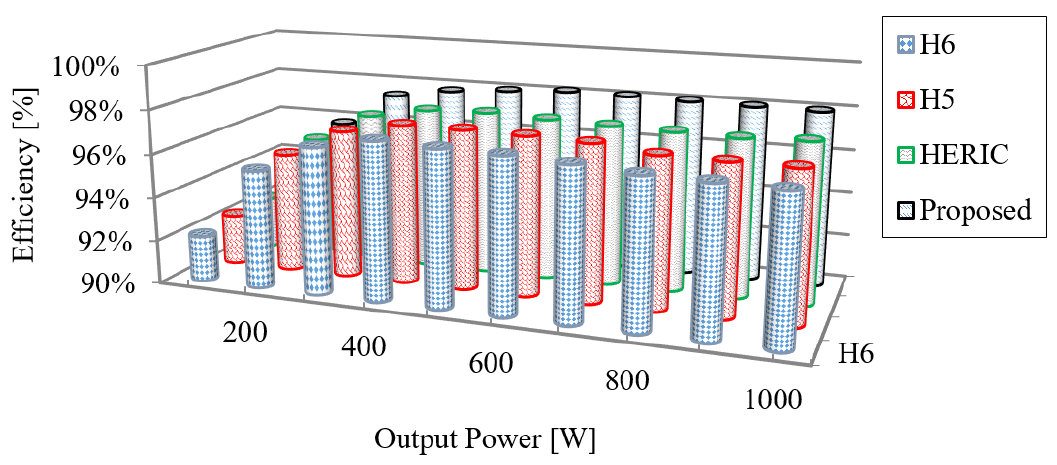
Figure 12. Efficiency evaluation in terms of output power. Table 3. Comparison as function of components number, total harmonic distortion (THD), i cm , and other properties. HERIC: highly efficient and reliable inverter.